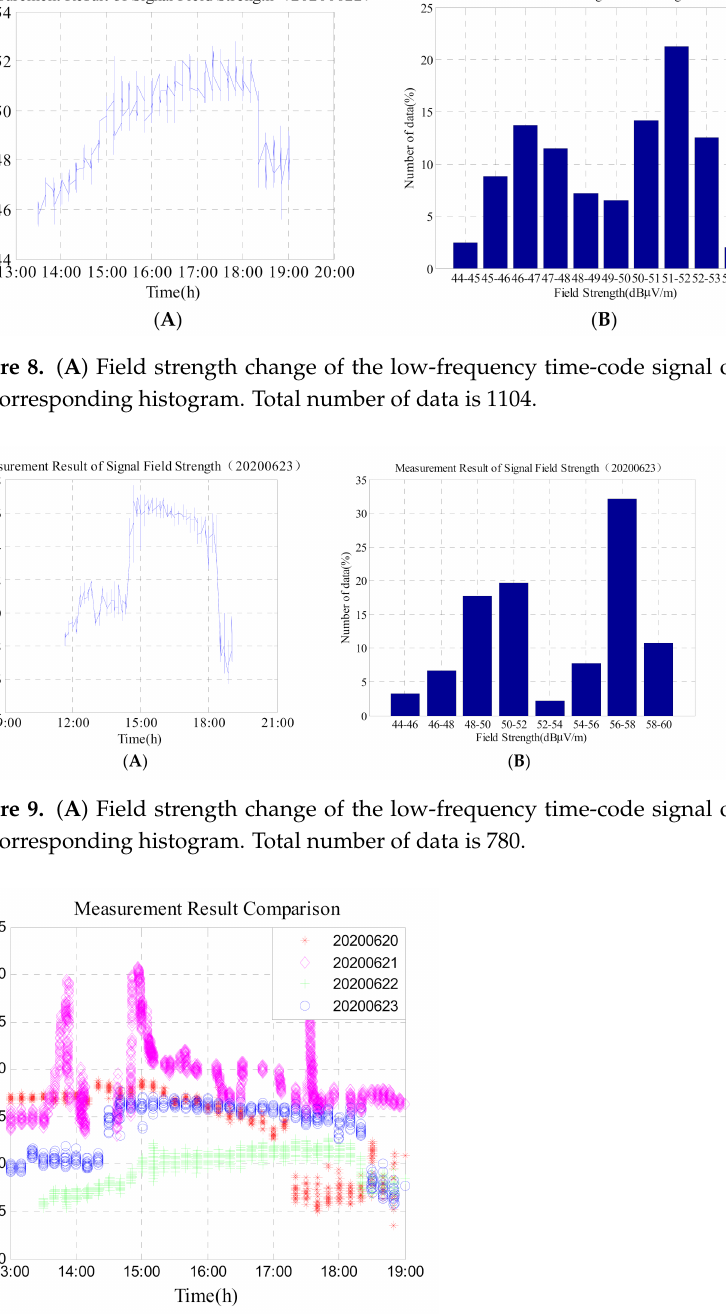
Figure 10. Field strength comparison of low-frequency time-code signal on the day of the annular eclipse and on the days before and after